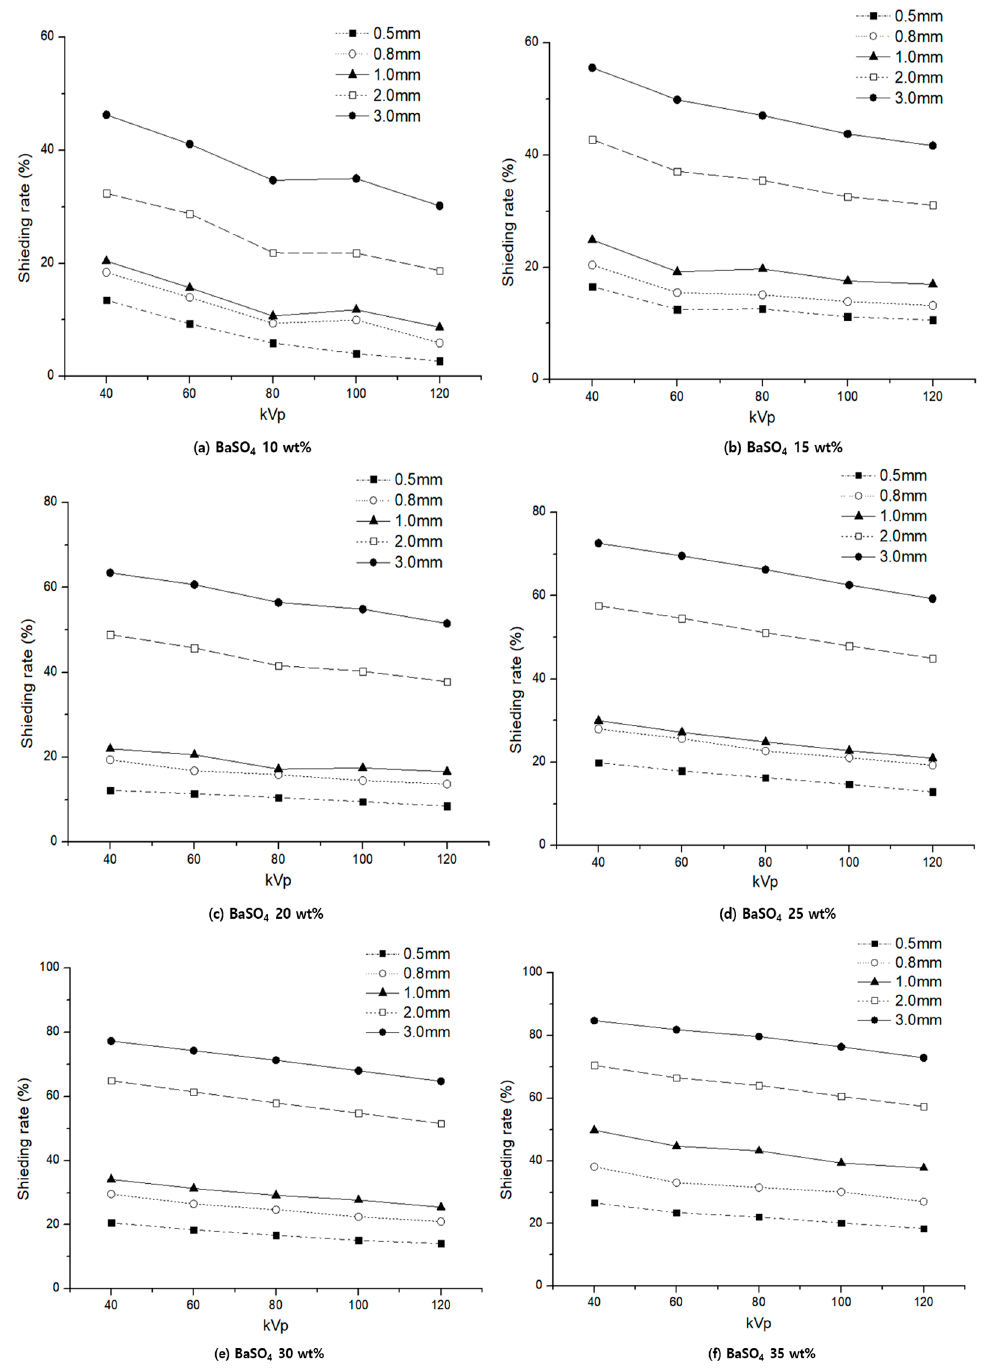
Figure 5. Comparison of shielding rate by wt% by thickness (barium sulfate). From the graph, when comparing the shielding performance by incident energy and thickness, a difference is shown in the low-energy region. However, there is no significant difference in the region with high tube voltage, which is the region with high energy strength. In addition, the higher the wt% of the shielding material in the protective cream, the better the shielding